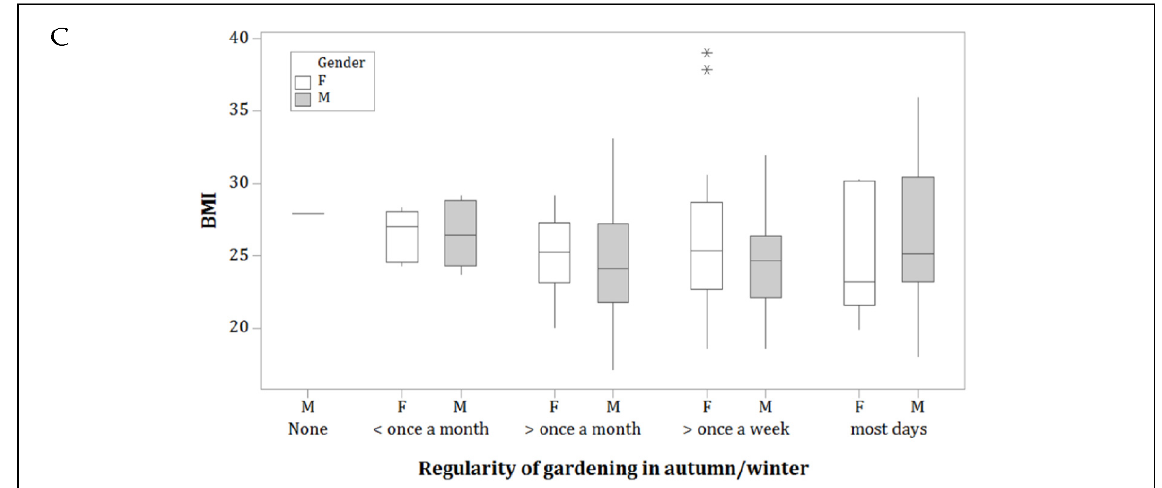
Figure 4. Gardening and lifestyle factors; ( A ) self-reported fruit and vegetable consumption (portions) over the previous 24 h and regularity of gardening in autumn/winter, ( B ) self-reported frequency of moderate exercise in the previous week and regularity of gardening in autumn/winter, ( C ) regularity with which participants took part in gardening activities in autumn/winter and BMI (kg m −2 ). Boxes show 25th, 50th and 75th percentiles; whiskers show 1.5 × IQR and * shows